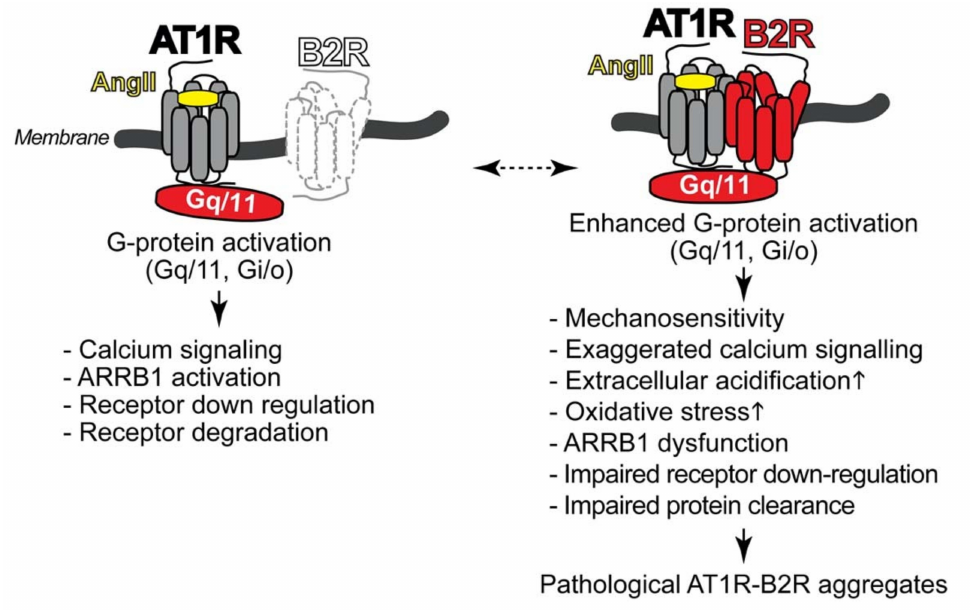
Figure 1. The AT1R-B2R protein complex forms a platform for enhanced G-protein activation. The scheme illustrates how protein complex formation between AT1R (angiotensin II receptor type 1) and B2R (bradykinin B2 receptor) facilitates the interaction with heterotrimeric G-proteins such as Gq/11 (heterotrimeric GTP-binding protein of Gq/11 family) and Gi/o (heterotrimeric GTP-binding protein of Gi/o family). As a consequence of stabilized G-protein interaction, stimulation of the AT1R-B2R protein complex with angiotensin II (AngII) or mechanical stimulation leads to enhanced G-protein activation and signaling, and beta-arrestin1 (ARRB1) dysfunction ( right side ) compared to the monomeric AT1 receptor ( left side ). This Figure was adapted from